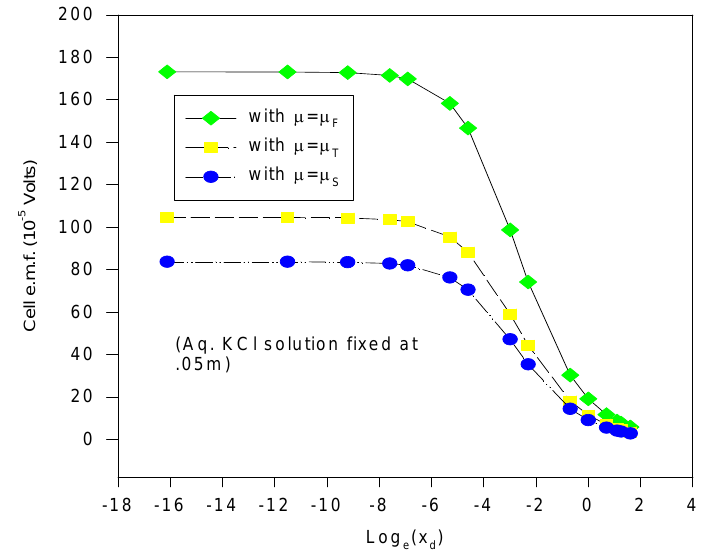
Figure 10. Cell e.m.f. computed for various µ and Helmholtz Inner layer distances X